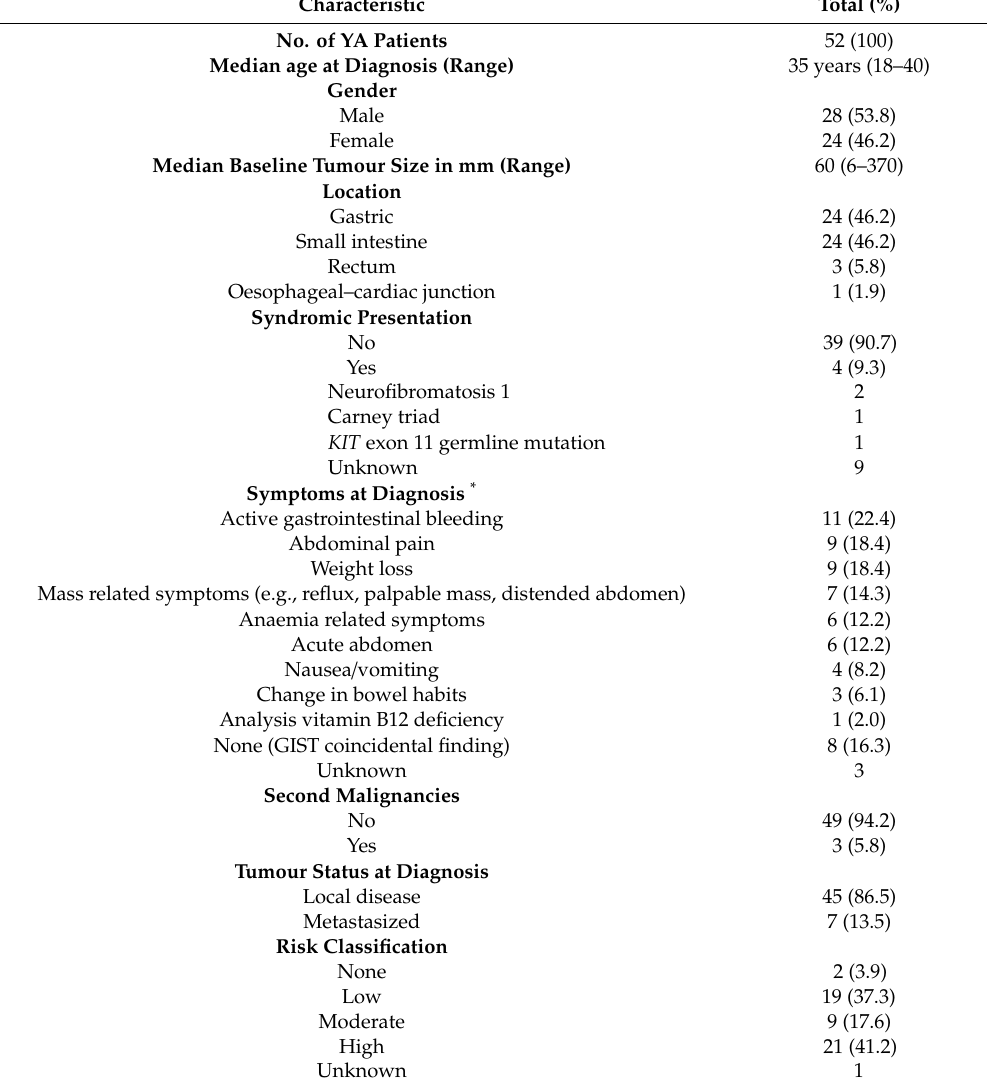
Table 1. Clinical and tumour characteristics of total young-adult (YA) age